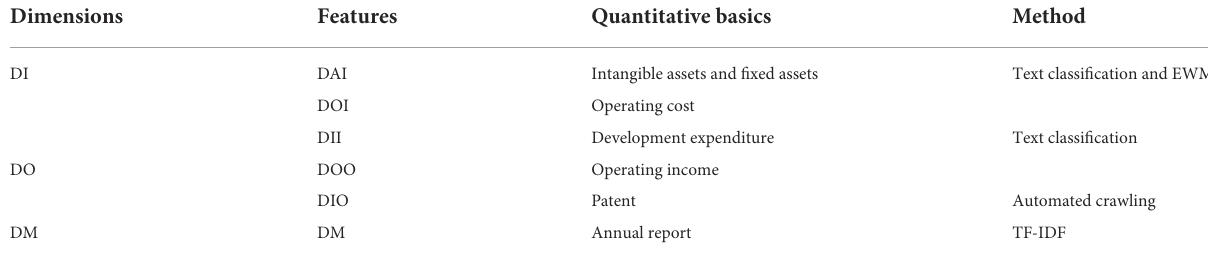
TABLE 1 The implications of digitalization